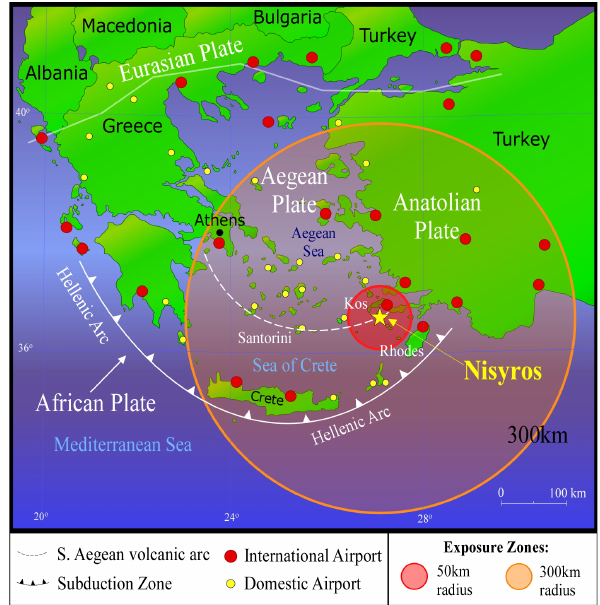
Fig. 5. Possible impact of volcanic eruption on Nisyros on regional air travel as quantified by circular areas with 300km and 50km ra- dius, respectively. The figure also shows the location of Nisyros in the tectonic context of the Hellenic Arc and location of all interna- tional and domestic airports within the proposed impact